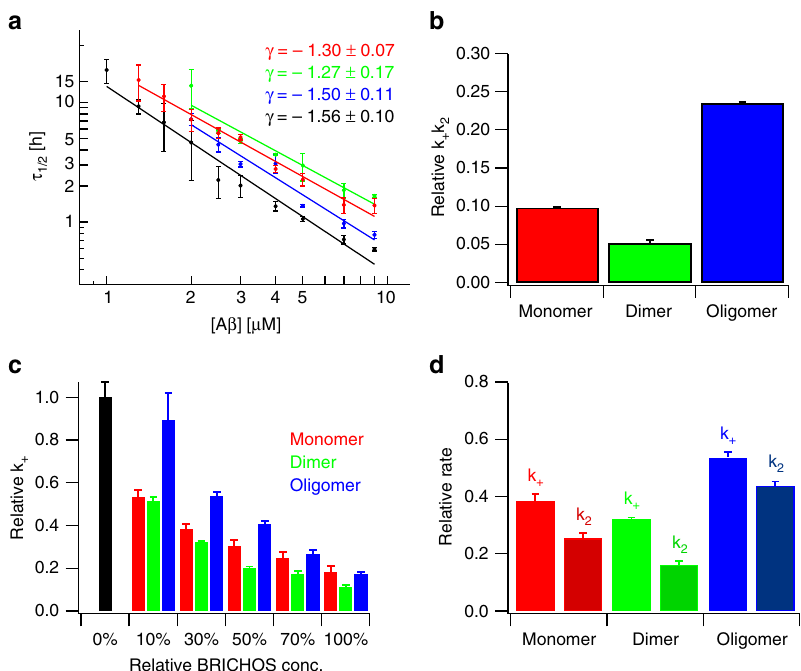
Fig. 4 Effect of rh Bri2 BRICHOS on the nucleation mechanism of A β 42. a A β 42 in the absence (black) and presence of 0.9 µ M Bri2 BRICHOS monomers (red), dimer (green) and oligomer (blue) exhibit a very similar dependence of the aggregation half time, τ 1/2 , on the initial peptide monomer concentration, described by the γ -exponent. b A global fi t analysis from the data set in a revealed a dominate effect in k þ k 2 , related to secondary nucleation and fi bril-end elongation, where the Bri2 BRICHOS dimer is the most ef fi cient species. c Estimation of the elongation rates from highly pre-seeded aggregation kinetics. d Estimated effect on the individual rate constants k + and k 2 from b and c by the different Bri2 BRICHOS species. The data in a and c are presented as means ± standard deviations of 3 – 6 replicates of experiments that have been repeated at least fi ve times with qualitatively similar results. The errors of the γ -exponent in a and errors presented in b refer to the fi tting errors. The errors in d are derived from the errors presented